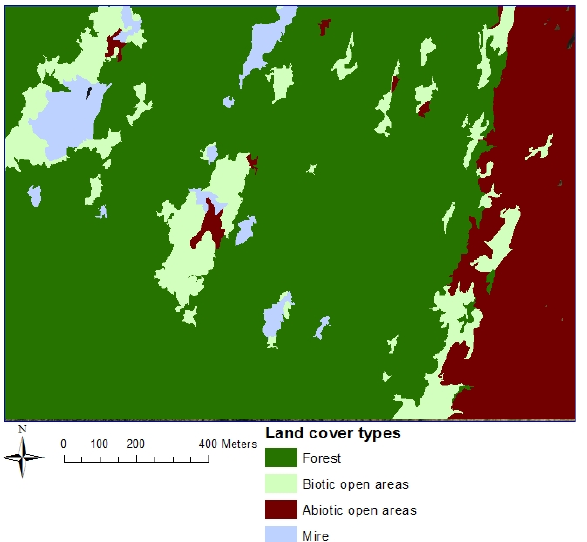
Figure 4. Classification result of the example tile